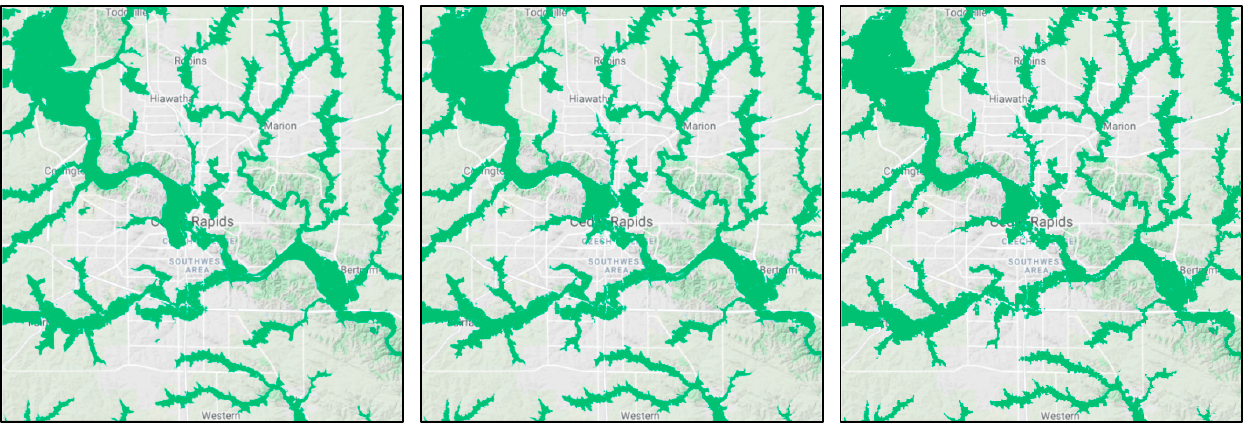
Figure 6. Maps generated for Cedar Rapids, Iowa with HAND model using 10 m, 25 m, and 50 m (left to right).